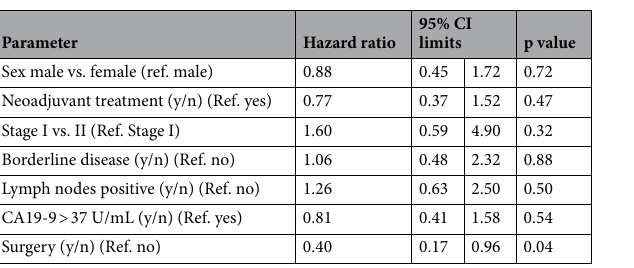
Table 3. Multivariable analysis for overall survival in localized pancreatic cancer patients. Surgery was the only parameter statistically associated with survival on multivariable analysis. Level of significance p < 0.05. Ref